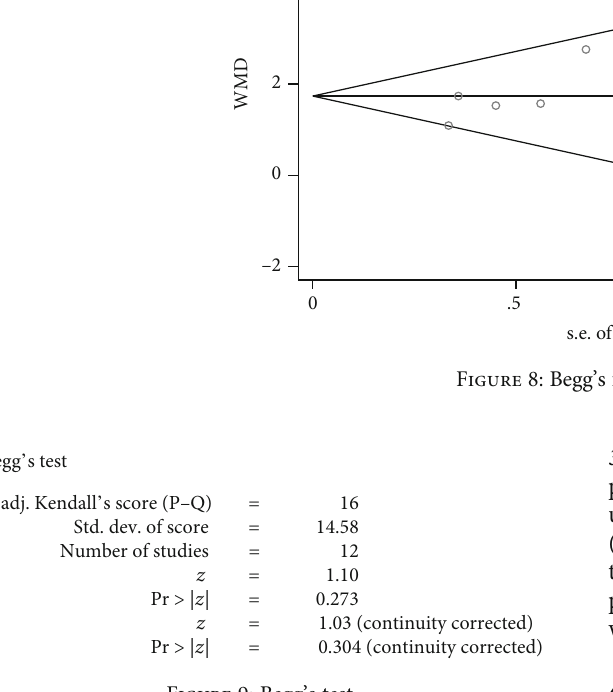
Figure 9: Begg ’ s